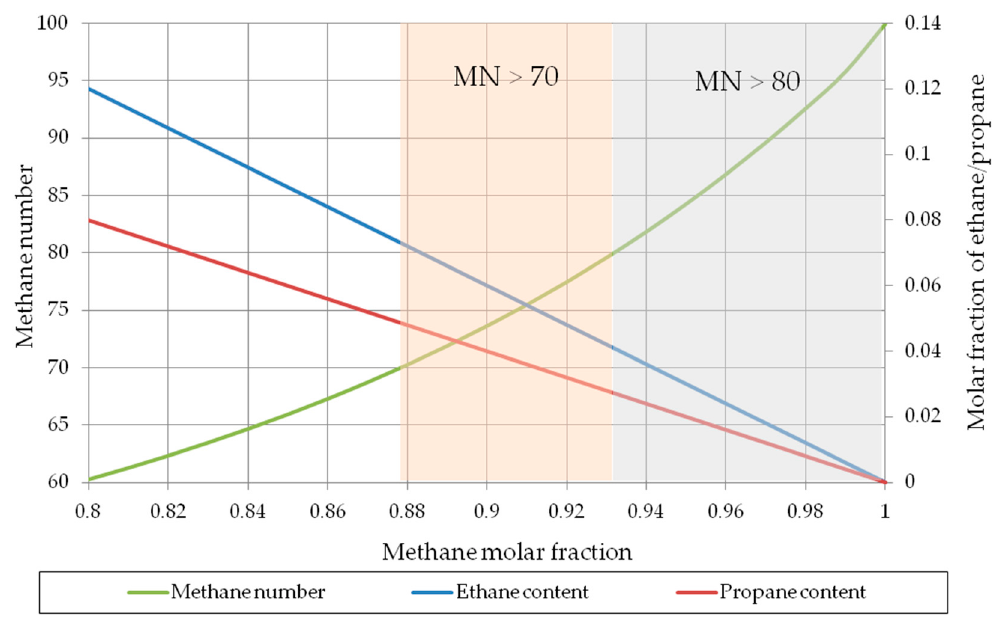
Figure 7. Methane number as function of methane and other components molar fraction for LNG composition set